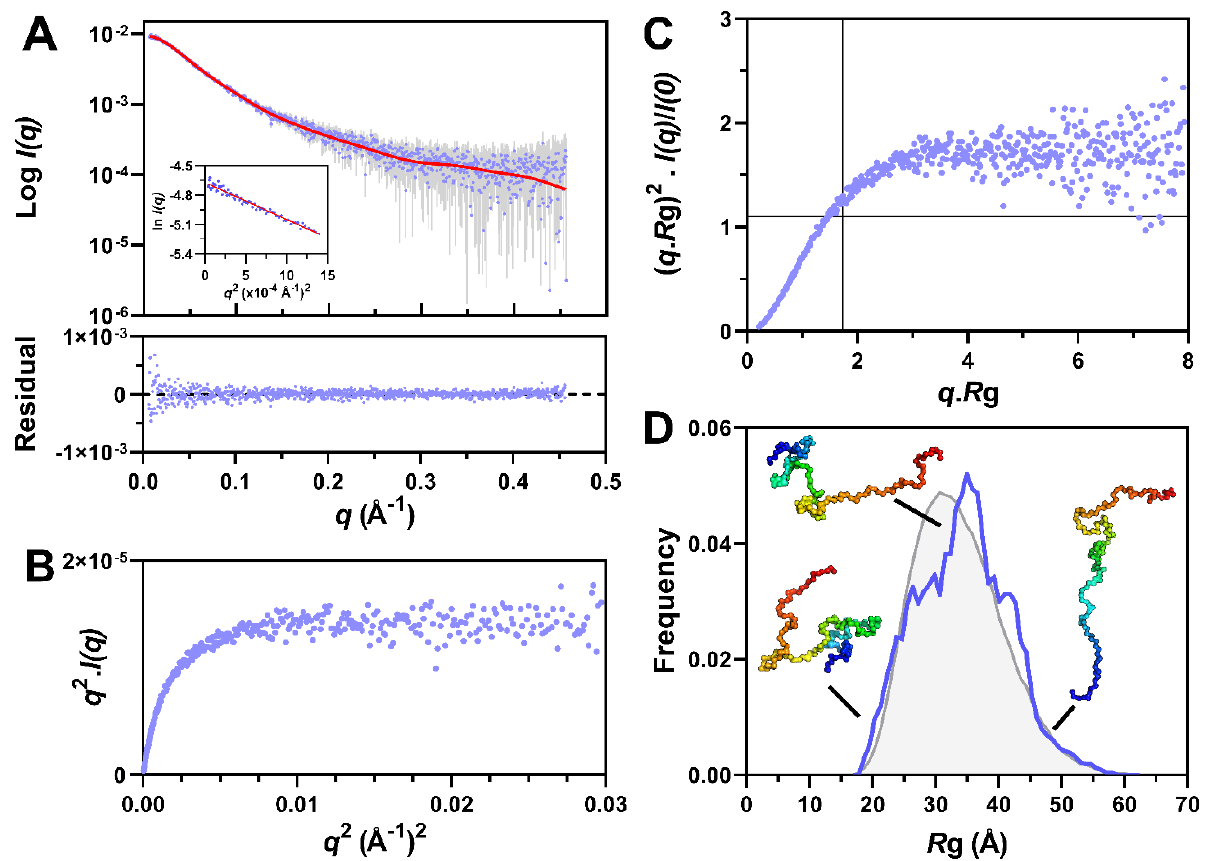
Figure 7. SEC-SAXS analysis of the monomeric form of PNT3. ( A ) Scattering intensities of PNT3 as resulting from the Gaussian deconvolution (blue) and EOM fit (red line). The bottom panel shows the plot of residuals between the deconvoluted scattering curve and the curve back-calculated from the EOM ensemble. Insert: R g determination according to the Guinier approximation. ( B ) Kratky–Debye plot. ( C ) Normalized Kratky plot. Black lines indicate the maximum of a bell-shaped curve observed for globular proteins. ( D ) R g distribution of the ensemble selected by EOM (blue, average R g = ~35 Å) and of the initial random coil pool of conformers (grey, average R g = ~34 Å). Three representative low-resolution conformers are shown. The structures were drawn using Pymol 2.0.1 (https://pymol.org/2/)